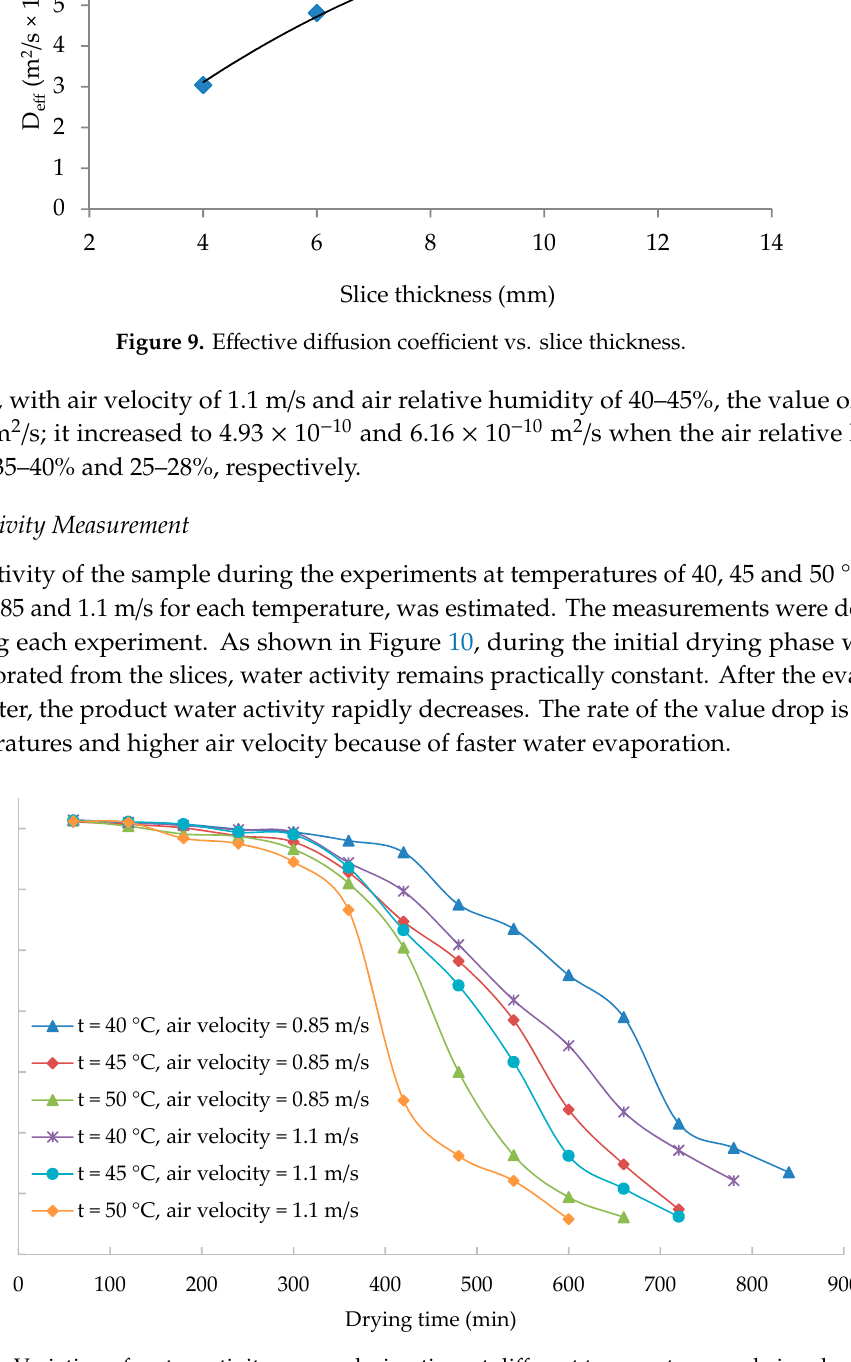
Figure 8. Effective diffusion coefficient vs. temperature and air velocity.